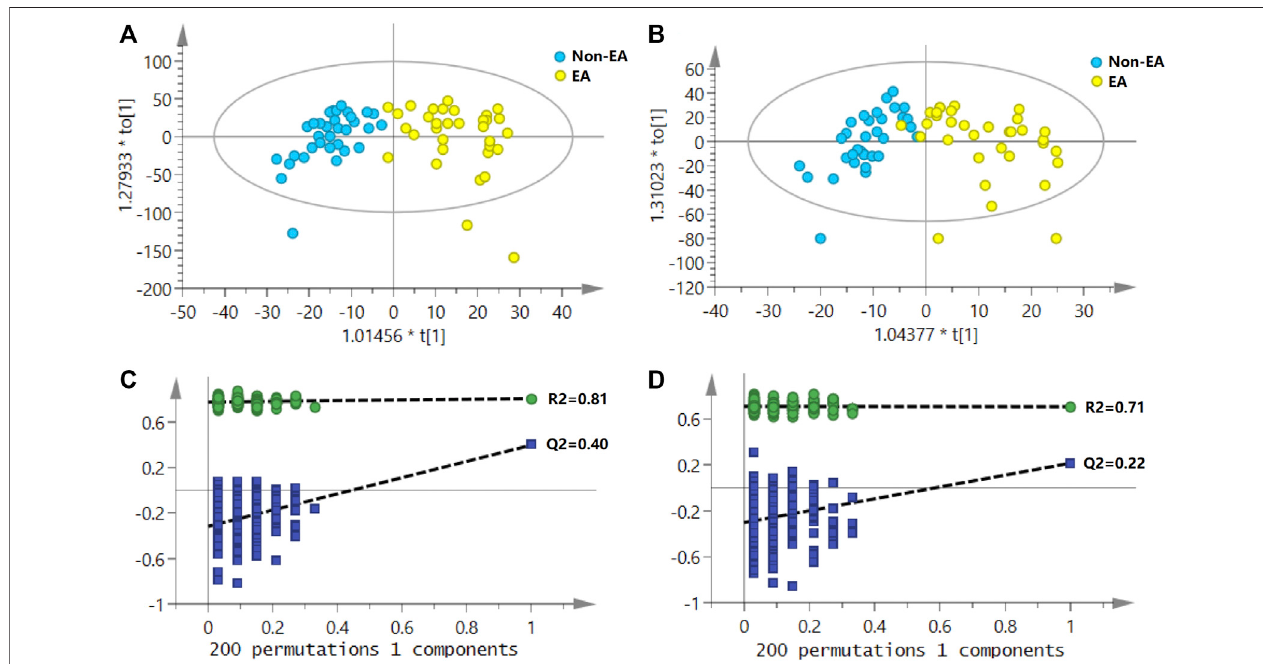
FIGURE 2 | Score plots of OPLS-DA for the urine metabolomics of emergence agitation (EA) versus the non-EA patients; (A) the positive ionization mode; (B) the negative ionization mode. The permutation test (200 tests total) for the OPLS-DA model; (C) in the positive ionization mode, R2Y and Q2Y were 0.81 and 0.40, respectively; (D) in the negative ionization mode, R2Y and Q2Y were 0.71 and 0.22, respectively.